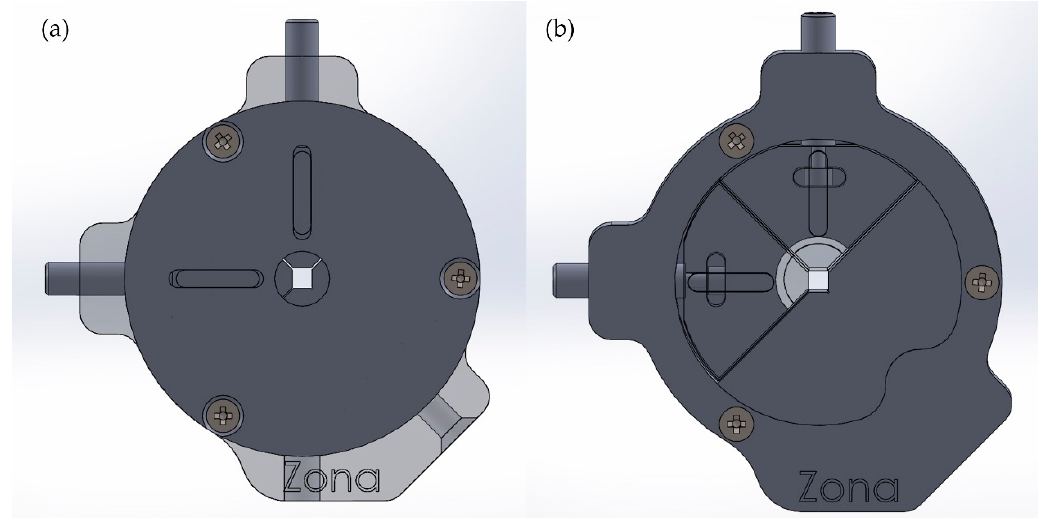
Figure 3. Fiber clamps that are specifically designed for the application. For our measurements, it is essential that the elastic fiber is reproducibly clamped without being twisted or squeezed. ( a ) Closed view of one fiber clamp, and ( b ) open view to visualize the clamping mechanism.